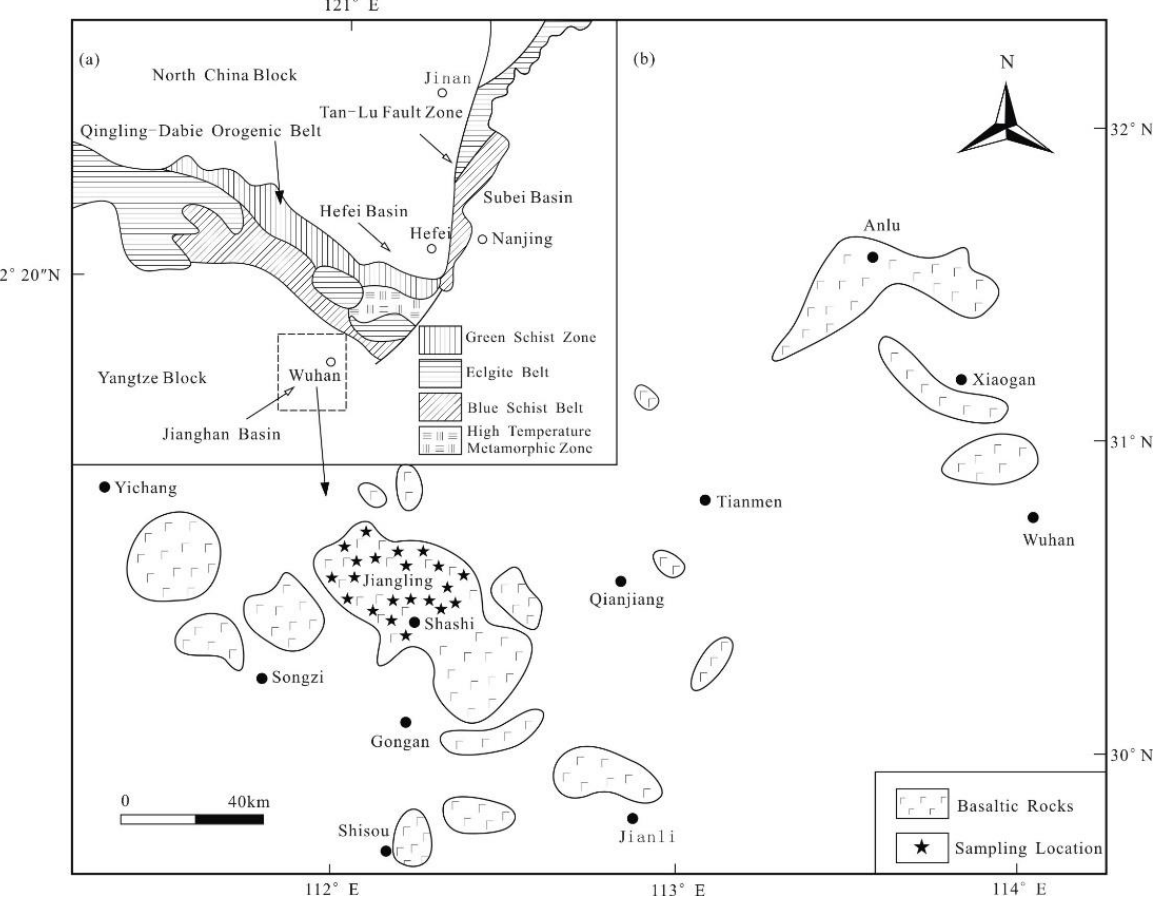
Figure 1. (a ) Tectonic division of Central China. ( b ) Geological map of the Jiangling Basin and sampling